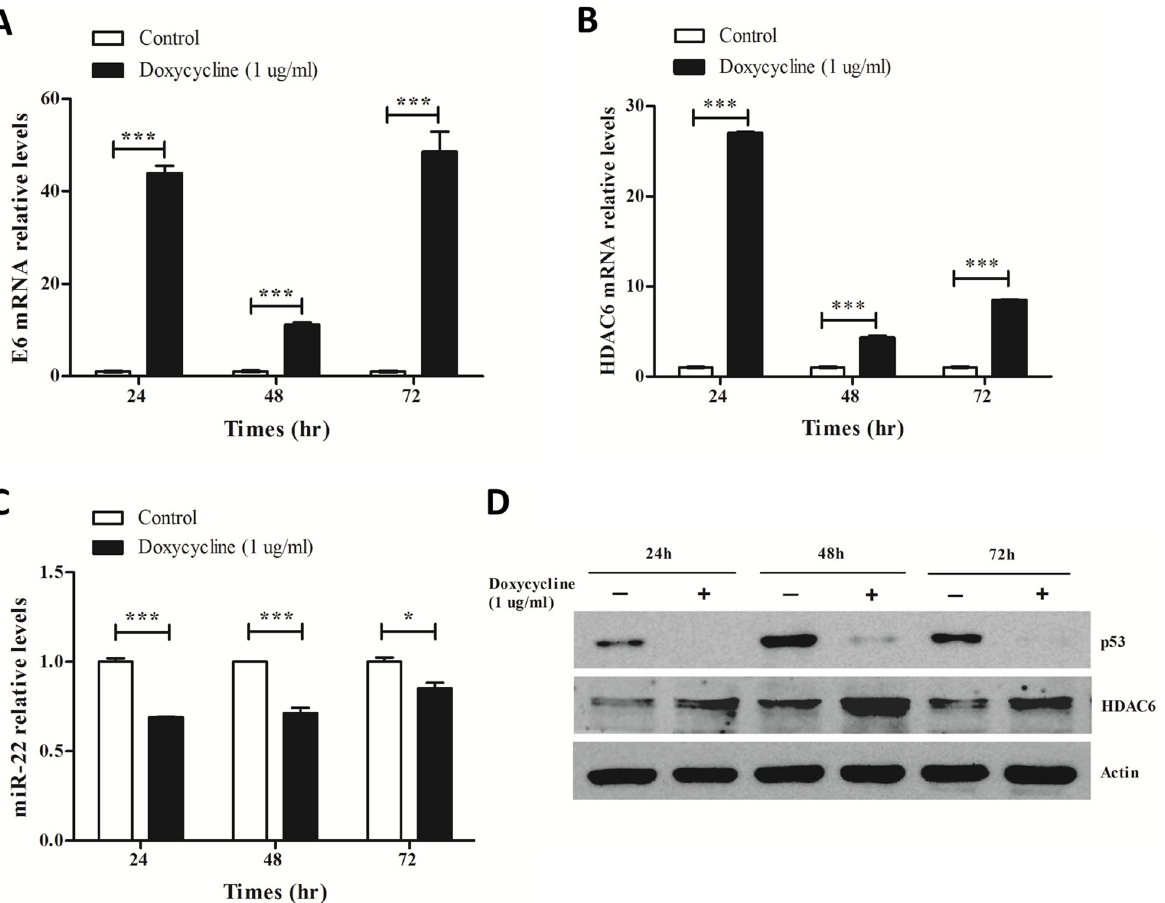
Fig 4. E6, p53, miR-22 and HDAC6 expression levels in HCK1T cells expressing HPV16 E6. 1x10 6 cells were seeded in 60-mm tissue culture dishes and maintained in growth medium with/without 1 μ g/ml doxycycline. Expression levels of E6 mRNA ( A ), HDAC6 mRNA ( B ) and miR-22 ( C ) at different time points were examined by qRT-PCR. D. p53 and HDAC6 protein levels were analyzed by western blot. Error bars indicate the standard error of the mean (SEM) of triplicated independent experiments. � P < 0.05, ��� P < 0.001.